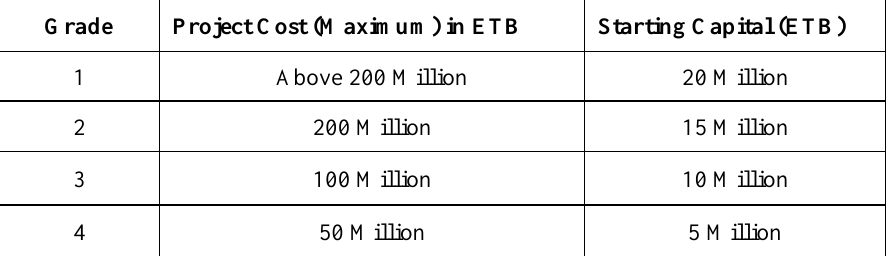
Table 1. Contractor Grade for Water Works Contractor (MoUD, 2013) Grade Project Cost (Maximum) in